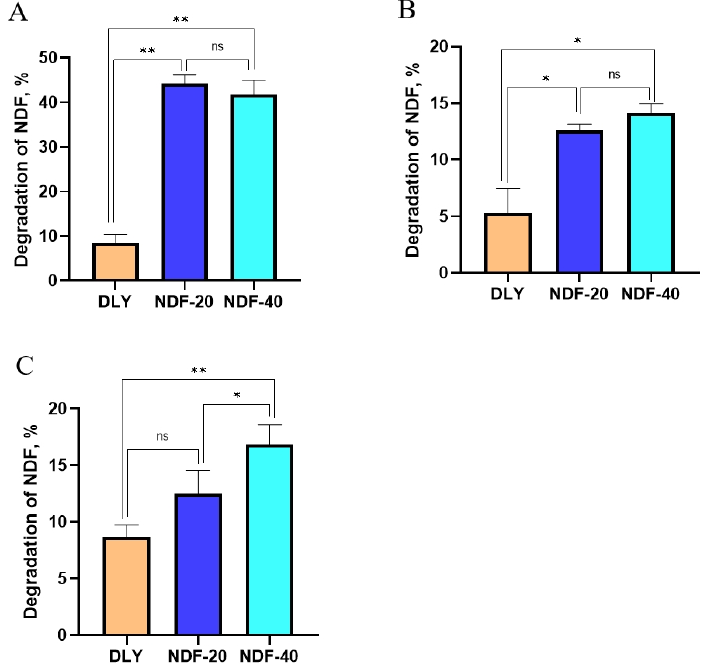
Figure 1. Comparison of NDF degradation ability between fecal microorganisms of Diqing Tibetan pigs and DLY pigs. ( A ) Commercial complete formula feeds of DLY pigs and Diqing Tibetan pig feed, of which NDF contents were ( B ) 20% and ( C ) 40%, were selected as fermentation substrates, and feces from Diqing Tibetan pigs and DLY were selected as starter culture. * p < 0.05; ** p < 0.01, and *** p < 0.005. The degradation ability of fecal microorganisms in Diqing Tibetan pigs was different for diverse types of fibers (Figure 2A). Among them, the degradation of NDF in oat bran was significantly higher ( p < 0.05) than that of wheat bran and highland barley hulls in both NDF-20 and NDF-40 groups, while the degradation of NDF in wheat bran was sig- nificantly higher ( p < 0.05) than that of highland barley hulls in both groups. When the substrates were wheat bran, oat bran, and highland barley hulls, neither NDF-20 nor NDF- 40 group showed significant differences ( p > 0.05) in the degradation rate of NDF (Figure 2B).